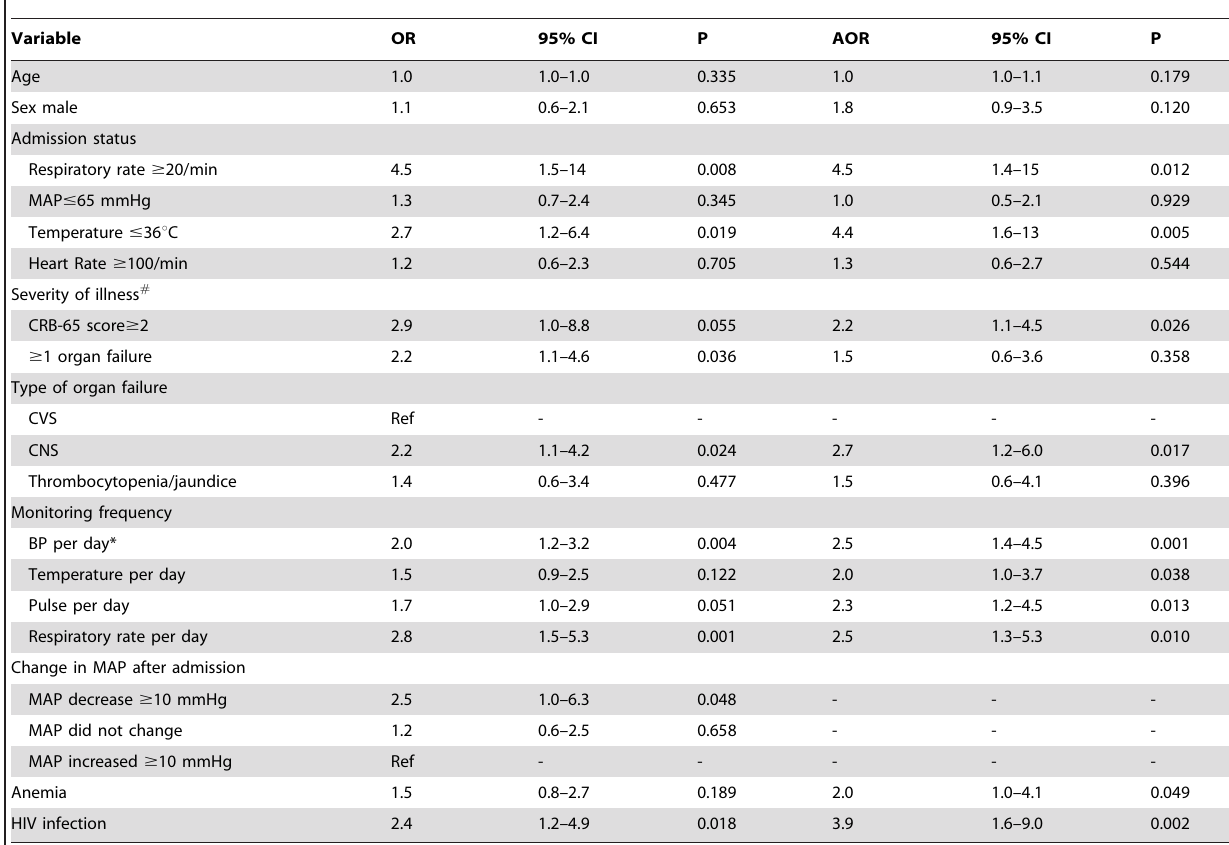
Table 2. Predictors of